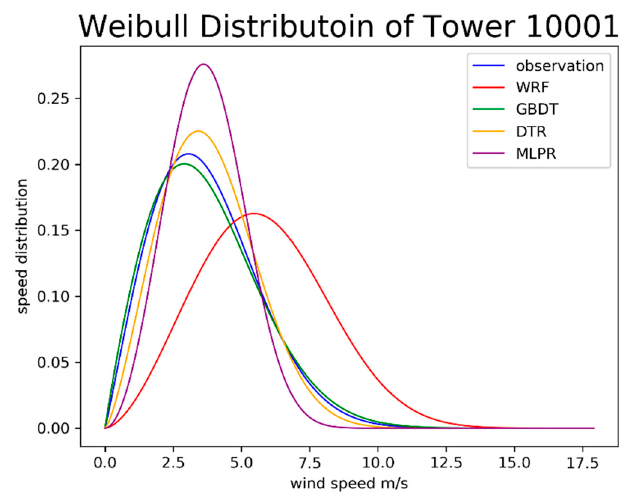
Figure 14. 10 m wind speed Weibull distribution of observation, WRF, GBDT, DTR, and MLPR on test data of Tower 10001. Table 12. Shape and scale parameters of 10 m wind speed Weibull distributions